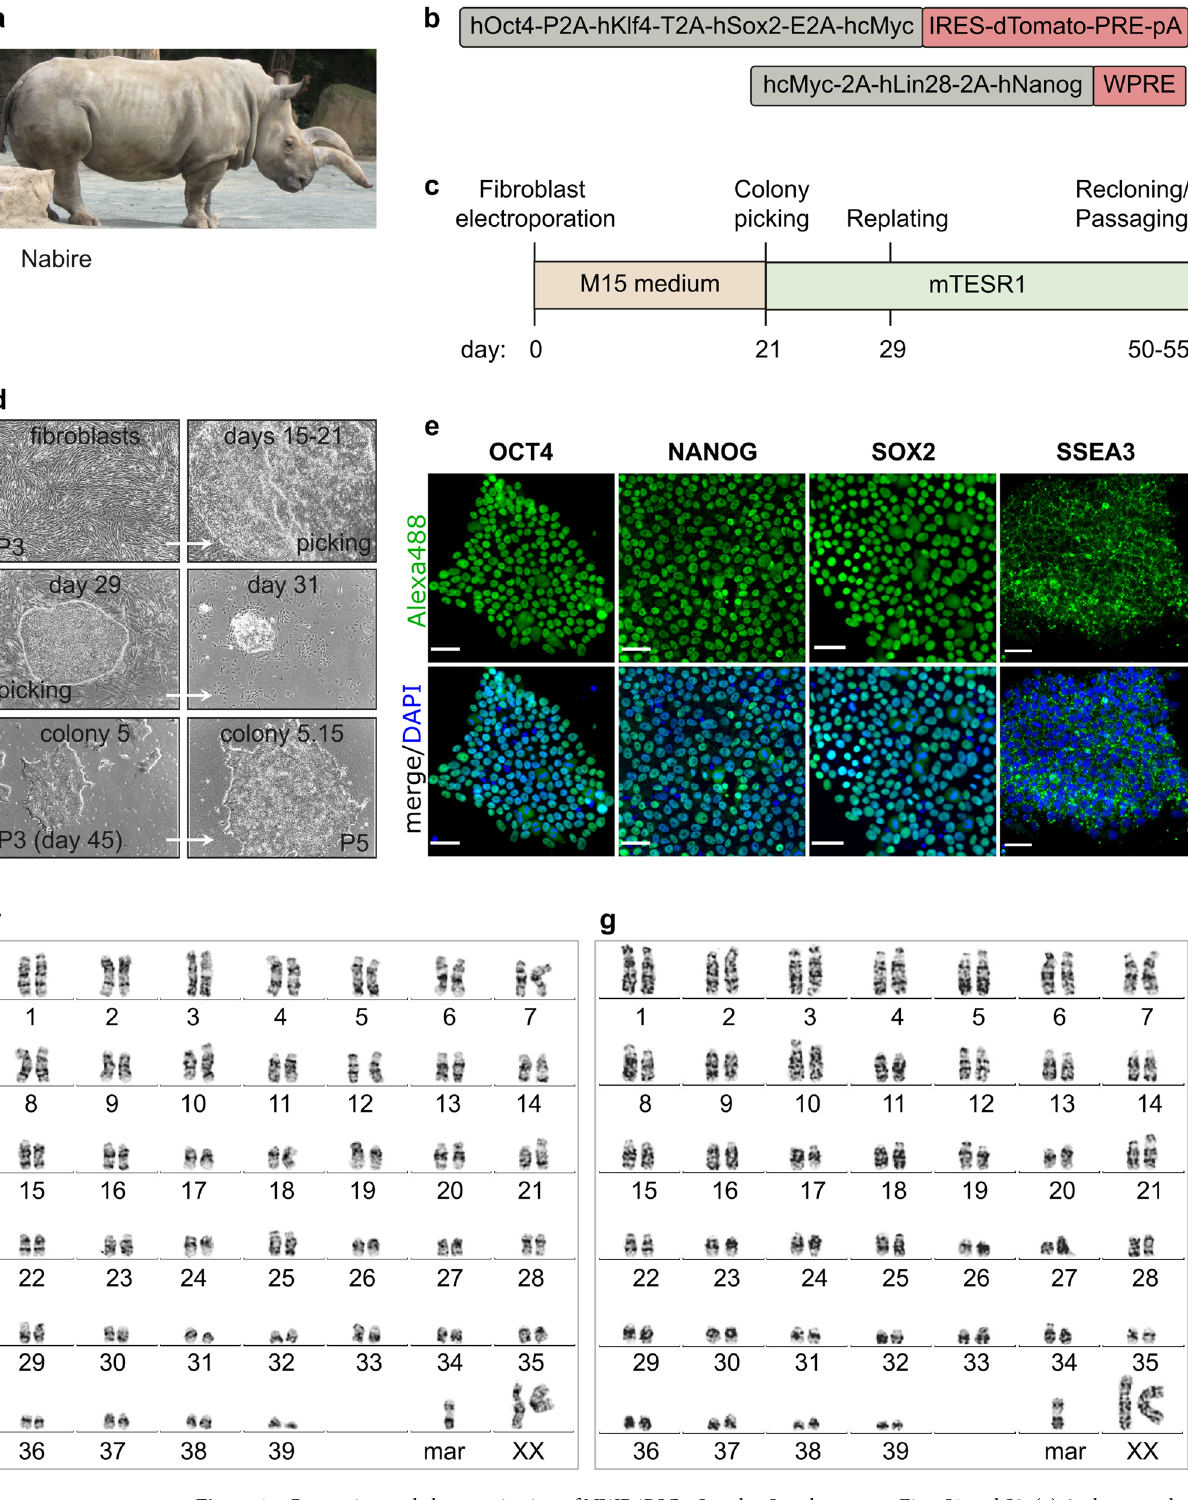
Figure 1. Generation and characterization of NWR iPSCs. See also Supplementary Figs. S1 and S2. ( a ) A photograph of the NWR Nabire. Author: Jan Robovský, Source: Groves et al. 23 ; Permission: Copyright: © 2010 Groves et al. This is an open-access article distributed under the terms of the Creative Commons Attribution License, which permits unrestricted use, distribution, and reproduction in any medium, provided the original author and source are credited. Changes: here, only Nabire is shown. ( b ) Scheme of the reprogramming vectors coMIP247 (top) and pCXLE-hMLN (bottom). ( c ) Timeline of the reprogramming strategy of NWR skin fibroblasts to iPSCs. ( d ) Representative cell images during reprogramming. All images were acquired with 10x magnification. Additional information in Supplementary Fig. S1. ( e ) Representative images of NWR iPSCs stained for the pluripotency markers OCT4, NANOG, SOX2, SSEA3. Scale bars: 50 µm. (f,g) Representative 2n = 81 chromosome complements of NWR Nabire skin fibroblasts ( f ) and NWR iPSCs ( g ). mar marker